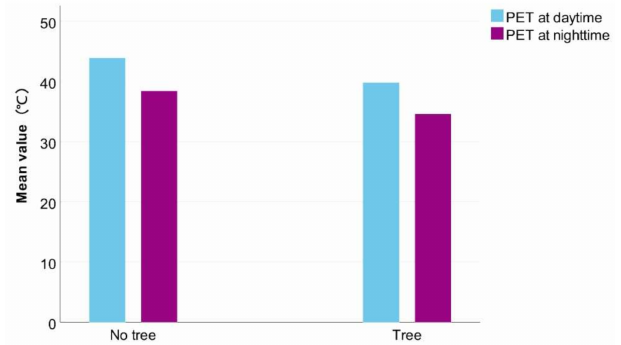
Figure 11. Comparisons of PET values with trees and with no trees, during the daytime and at nighttime.